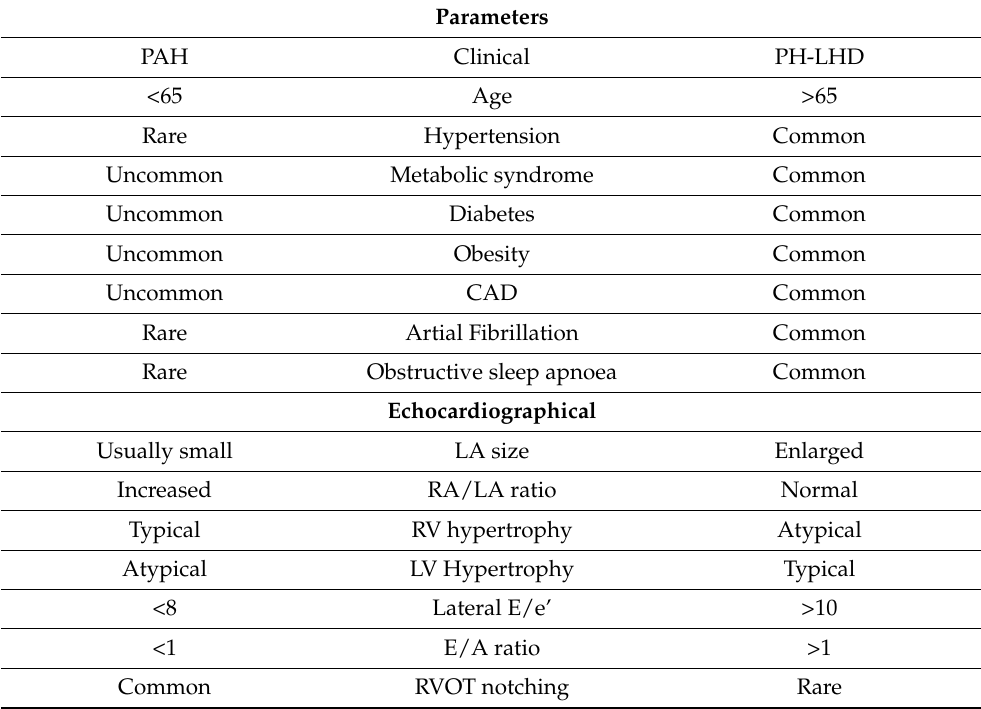
Table 1. Clinical, echocardiographic, and hemodynamic differentiation of pulmonary arterial hyper- tension and pulmonary hypertension in left heart disease. Parameters PAH Clinical PH-LHD <65 Age >65 Hypertension Common Metabolic syndrome Common Diabetes